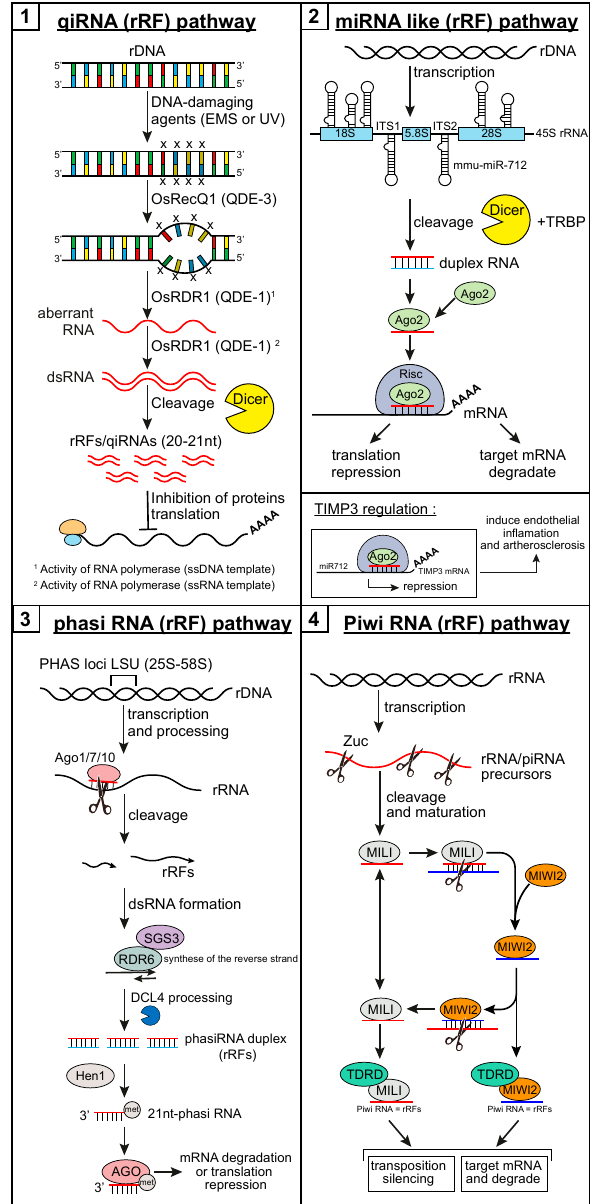
Figure 1. The biogenesis and function of ribosomal RNA-derived fragments. ( 1 ) QDE-2-interacting small RNAs (QiRNA)/ribosomal RNA-derived fragment (rRF) pathway discovered in fungi ( Neurospora crassa) [66], and recently found in plants, flies, and mammals [72,79–81]. These rRFs originate from ribosomal DNA (rDNA) after DNA damage, which is detected by OsRecQ1 (RecQ DNA helicase homologue/QDE-3). This leads to recruitment of OsRDR1 (RNA-dependent RNA polymerase [RdRp] homologue/QDE-1) at the single-stranded DNA (ssDNA) site, production of aberrant RNA (aRNA) from ssDNA, and conversion of the aRNA into double-stranded RNA (dsRNA) via its RdRp activity. Dicer processes the dsRNA substrate into qiRNA rRFs, which then serves as guide RNA to repress messenger RNA (mRNA) translation. ( 2 ) Native ribosomal RNAs (rRNAs) harbor microRNA (miRNA) sequences, which may be generated under specific conditions (e.g., stress). These miRNAs may be located in internal transcribed spacer (ITS1), as hsa-miRNA-663 in humans [65], or in ITS2, as mmu-miRNA-712 in mice [82]. In Opium poppy, two and three miRNAs are present in the 18S and 28S rRNAs, respectively [83]. These miRNAs/rRFs follow the noncanonical miRNA pathway and repress translation of its mRNA targets. For example, in mice, tissue inhibitor of metalloproteinase 3 (TIMP3) mRNA is repressed by mmu-miR-712. TIMP3 being an inhibitor of